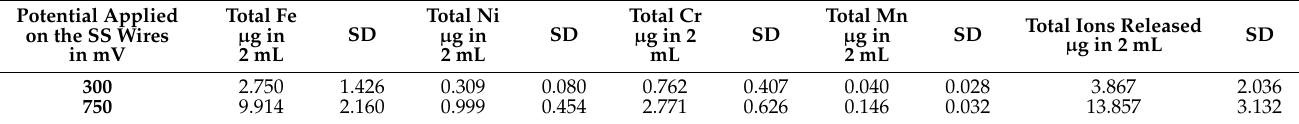
Table 9. The average expected ion release from the SS wires at 300 mV and 750 mV.